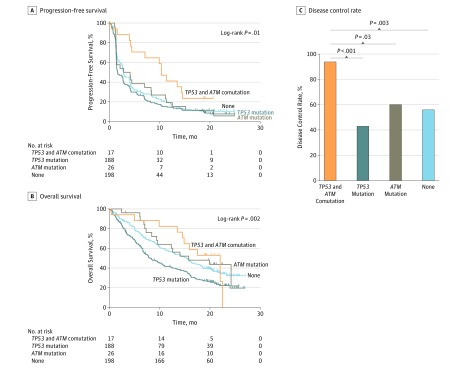
Association of TP53 and ATM Mutation Type With Prognosis and Response in the POPLAR4 and OAK20 CohortATM indicates ataxia-telangiectasia mutated gene; NSCLC, non–small cell lung cancer; TP53, tumor protein p53 gene; and crosses, patients who were censored.